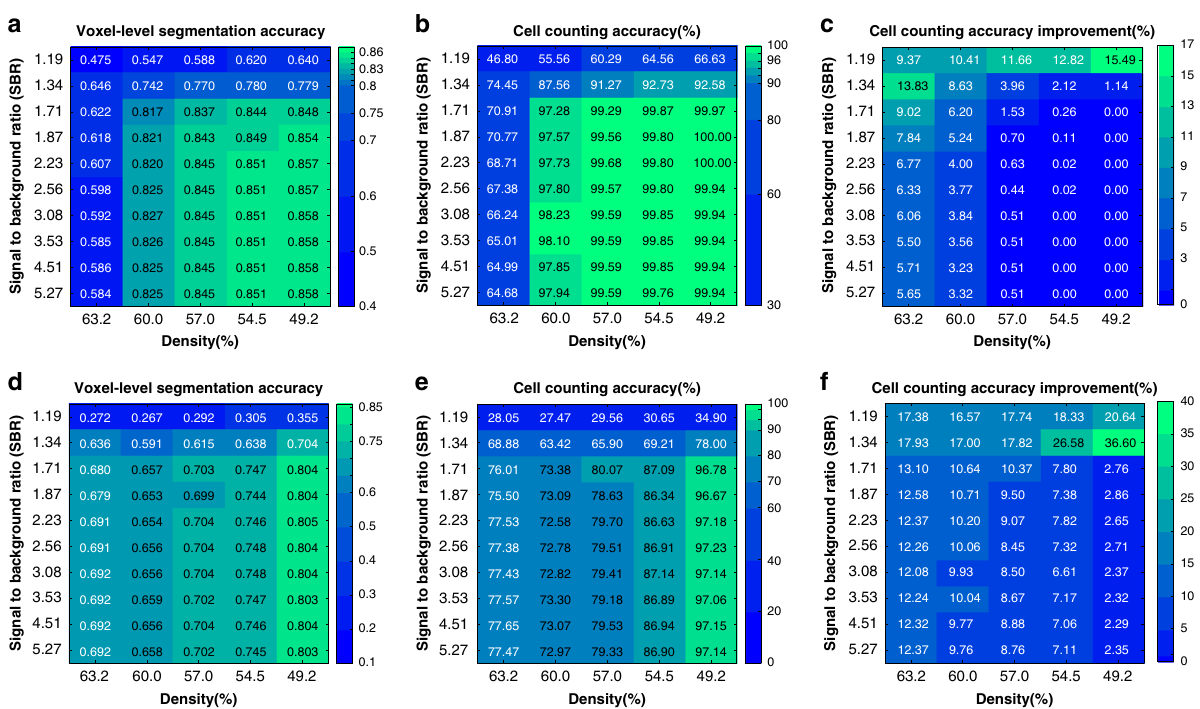
Fig. 3 Performance of BCM3D (in silico-trained CNNs and additional post-processing by LCuts) on previously unseen simulated data. a Voxel-level segmentation accuracy and b cell counting accuracy (using an IoU matching threshold of 0.5 for each segmented object) averaged over N = 10 replicate datasets for cells labeled with cytosolic fl uorophores. c Improvement relative to silico-trained convolutional neural networks without post-processing. d Voxel-level segmentation accuracy and e cell counting accuracy averaged over N = 10 replicate datasets for cells labeled with membrane-localized fl uorophores. f Improvements relative to silico-trained convolutional neural networks without